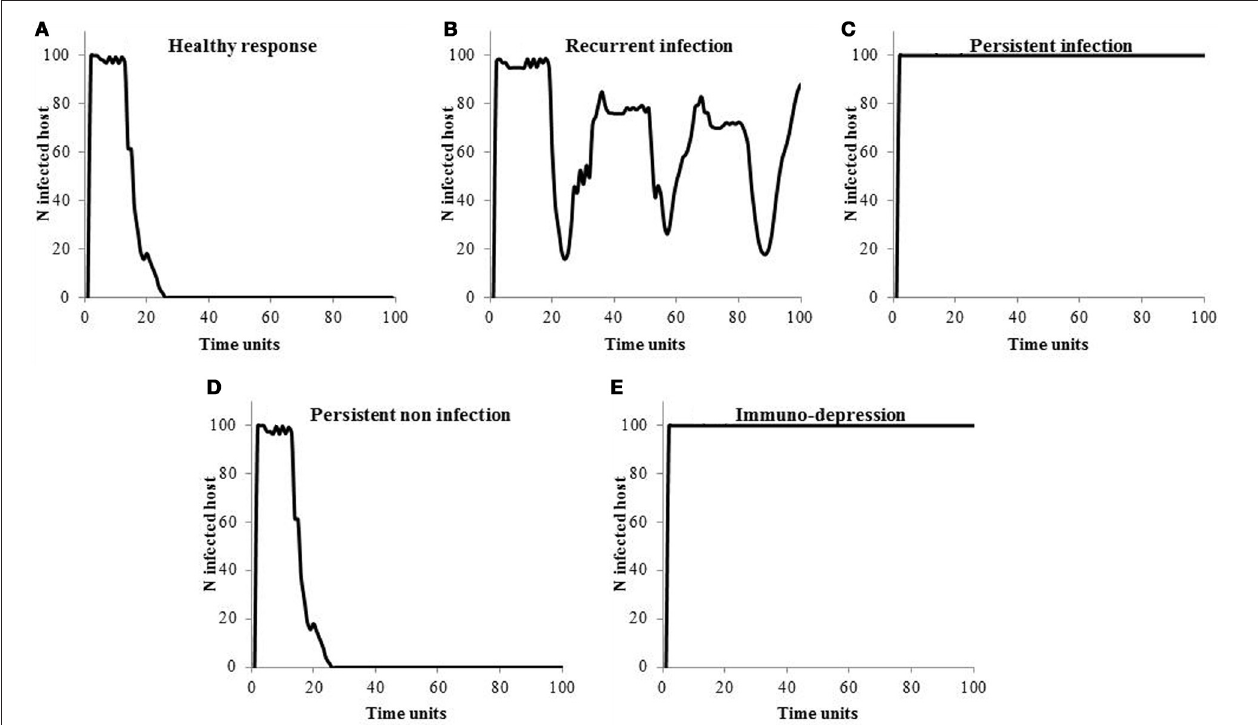
FIGURE 2 | Size of the endemics according to the scenario of response to